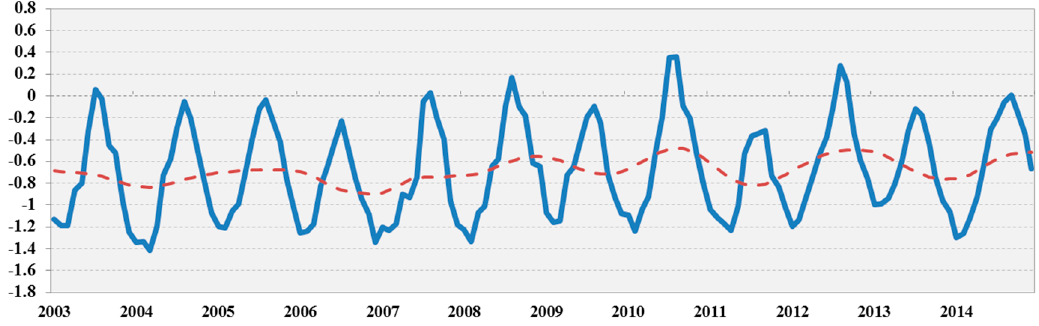
Figure 7. Time series of flood potential index (FPI, blue line) and associated inter-annual trends from Seasonal and Trend decomposition using Loess (STL) decomposition (red dotted line) of the Yangtze River Basin.